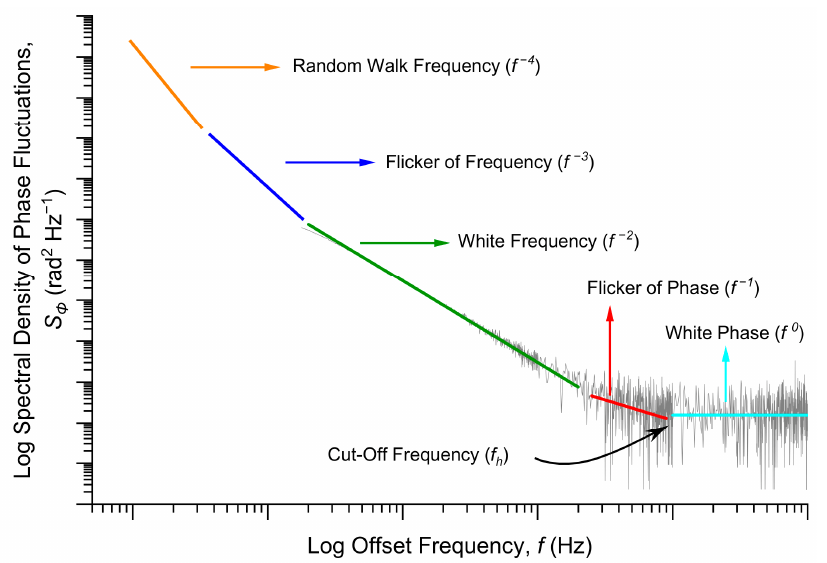
Figure 5. Power-laws of the spectral density of phase fluctuations, S Φ ( f ) , and corresponding noise mechanisms. A typical experimental curve of S Φ ( f ) is plotted in light grey. The cut-off frequency ( f h ) is also